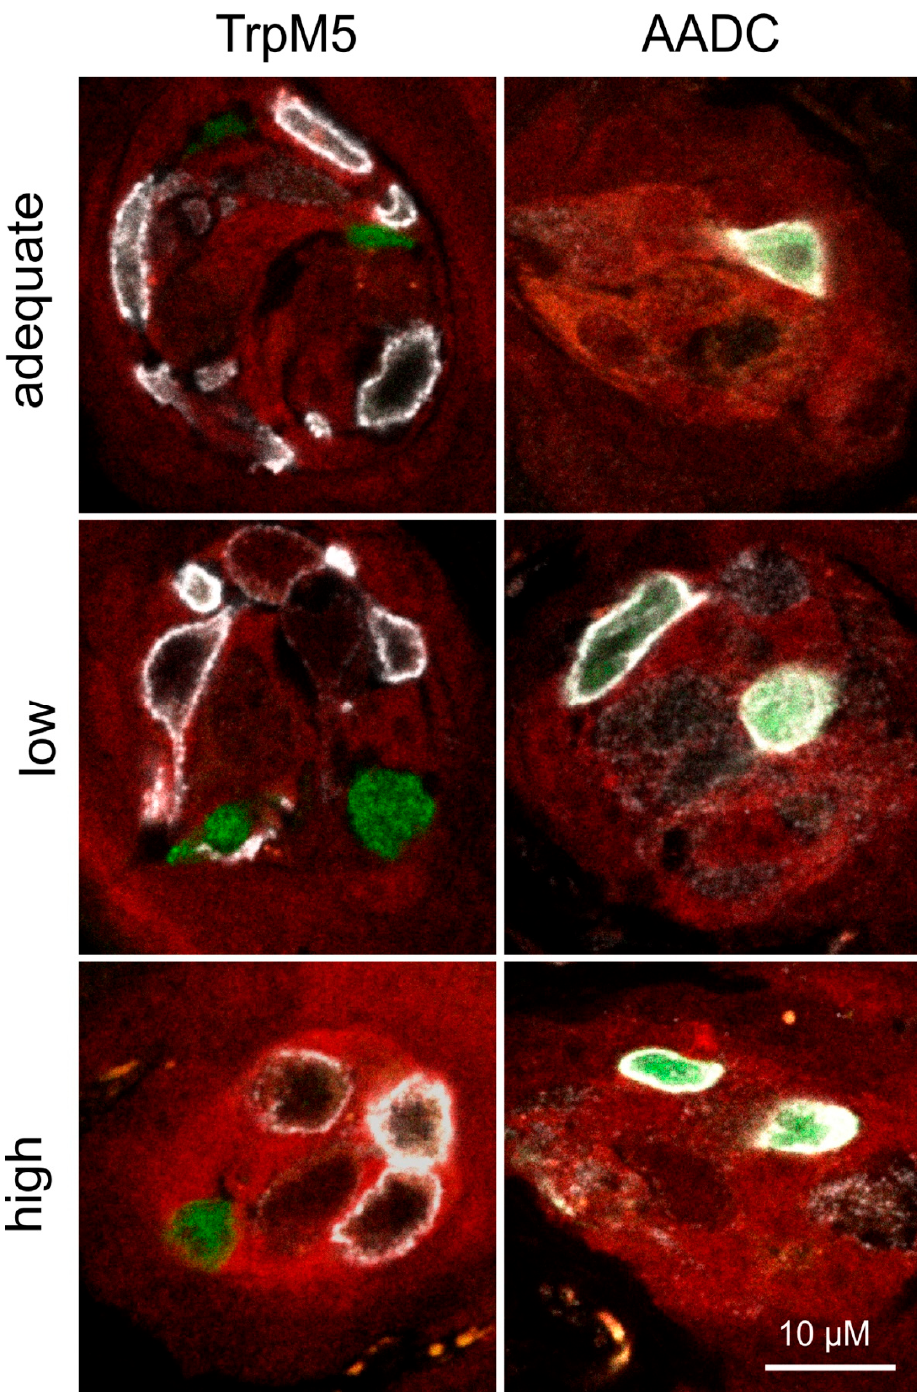
Figure 2. Expression of fluorescent proteins in fungiform papillae after dietary intervention. Fungiform papillae sections of Scnn1 aa/bb animals expressing GFP (synthesis of green) and tdRFP (synthesis of red) fluorescence in α ENaC- and β ENaC-expressing cells, respectively, were stained for Type II (TrpM5) and Type III (AADC) taste cell markers after dietary intervention. Therefore, animals received either an adequate, low, or high salt diet over a period of 4 weeks. Independently of the consumed diet, GFP and tdRFP fluorescence showed no co-localization in taste papillae. Whereas GFP-positive cells always co-expressed AADC, tdRFP-positive cells revealed no overlap with the cell markers TrpM5 or AADC, visualized by immunofluorescence (white). Scale bars apply to all images.